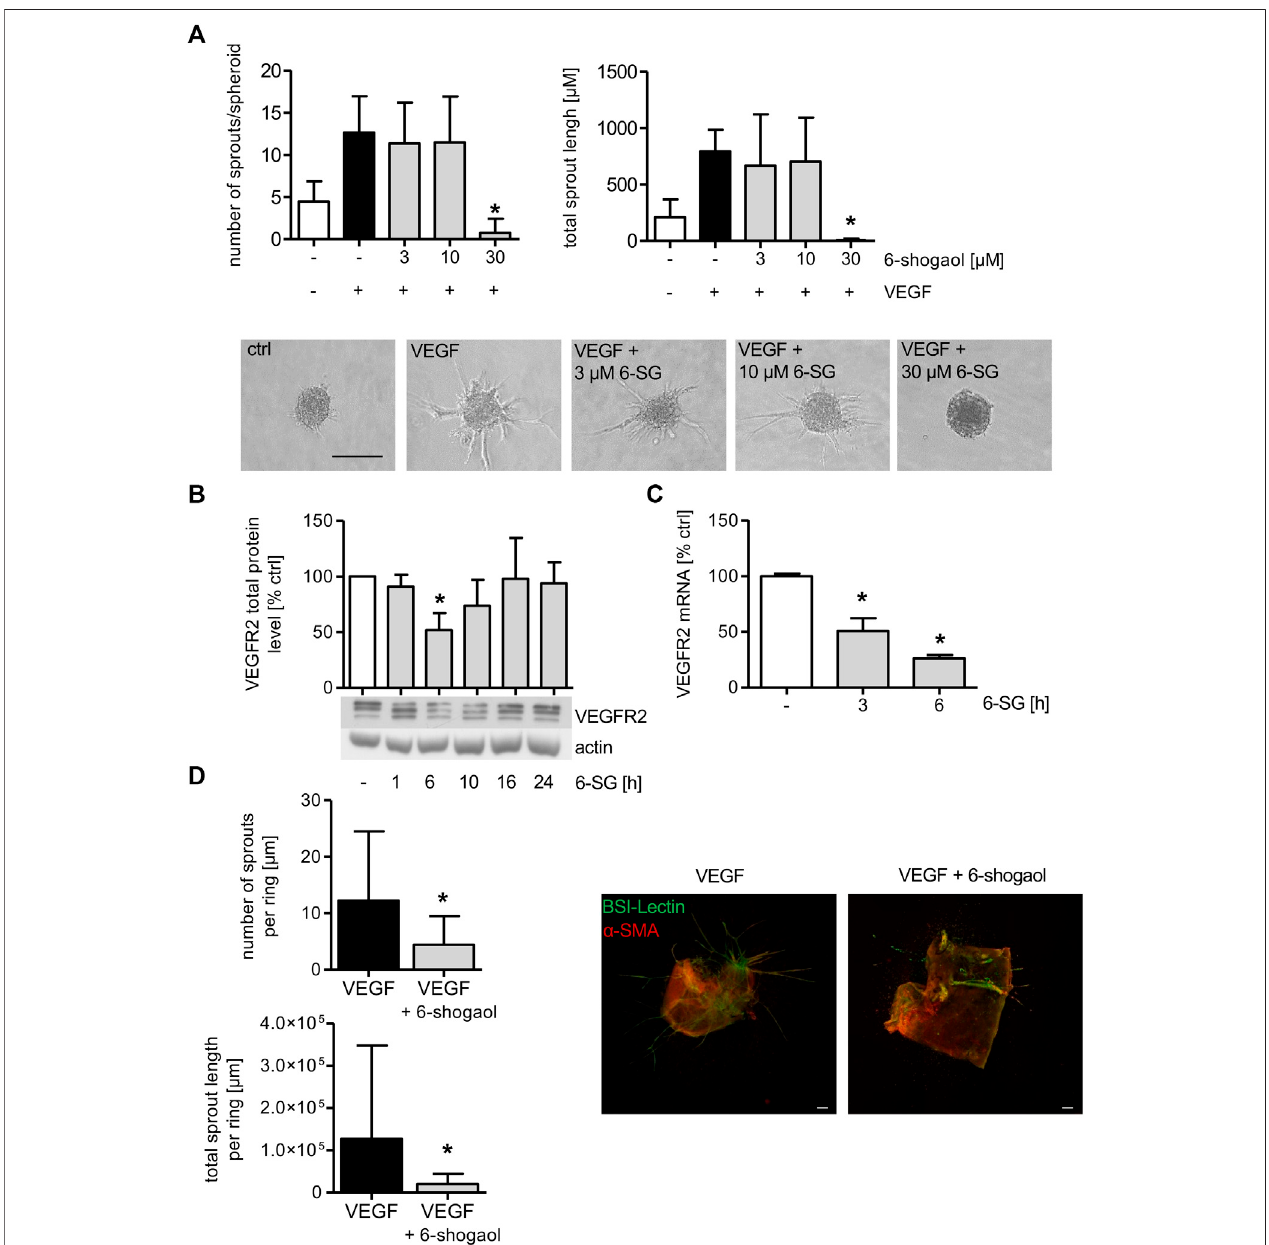
FIGURE 5 | Formation of endothelial sprouts from HUVEC spheroids or mouse aortic rings is signi fi cantly attenuated by 6-shogaol. (A) HUVEC spheroids comprised400cellsthatwereembeddedintoarattailcollagenIgel.Thespheroidsweretreatedwithindicatedconcentrationsof6-shogaolfor30 minbeforeendothelial sprouting was induced by VEGF (10 ng/ml). 20 h later, the spheroids were fi xed with 4% formaldehyde, and microscopic images were taken. Image quanti fi cation was performed using ImageJ. Scale bar represents 100 µm. One representative image for each condition is shown. (B,C) Con fl uent HUVECs were treated with 6- shogaol (30 µM) for indicated time points. (B) Total protein levels of VEGFR2 were determined by Western blot analysis. Actin served as the loading control. One representativeblotisshown. (C) VEGFR2mRNAdatawereobtainedbyqPCR.GAPDHservedasthehousekeepinggene. (D) Mouseaorticringswereembeddedintoa rat tail collagen I gel and stimulated with VEGF (30 ng/ml). After the formation of initial sprouts, the aortic rings were treated with 6-shogaol (30 µM) or vehicle (0.03% DMSO) for 3 days. Aortic rings were fi xed and stained with BS-I lectin (green) and for α -smooth muscle actin (red). Laser confocal scanning microscopy and ImageJ allowed the quanti fi cation of sprout number and length. Scale bar represents 100 µm, and one representative imageis shown. 6-SG: 6-shogaol. Data are expressed as mean ± SD; (A) n = 3; * p ≤ 0.05 vs. VEGF; (B) n = 3; (C) n = 3; * p ≤ 0.05 vs. ctrl; (D) n = 3; p ≤ 0.05 vs. VEGF.